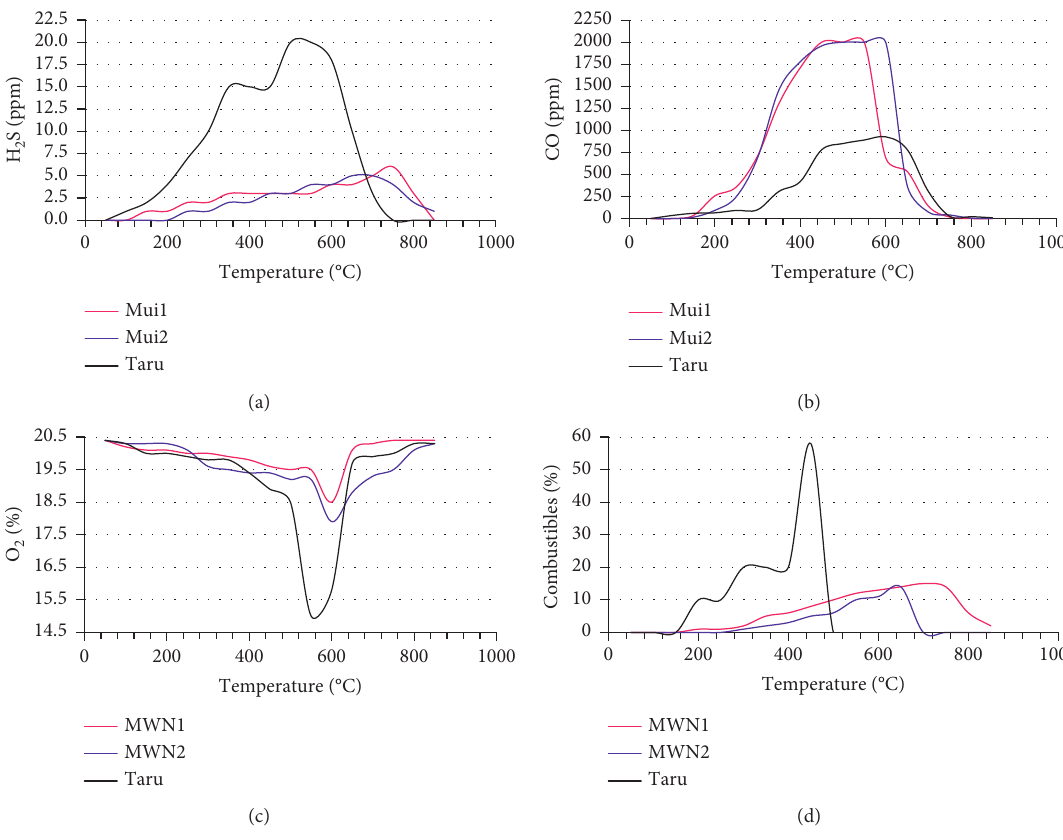
Figure 7: Plot of (a) H 2 S in ppm, (b) CO in ppm, (c) O 2 %, and (d) combustibles % against temperature. Table 1: Proximate results. Coal sample